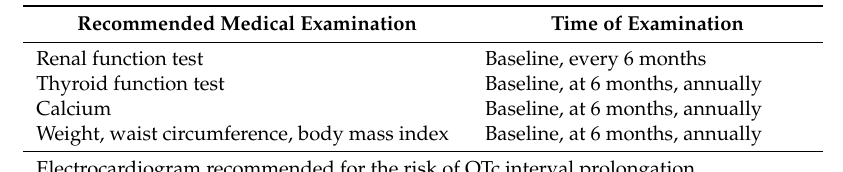
Table 1. Recommended medical examinations for safety monitoring with lithium treatment.